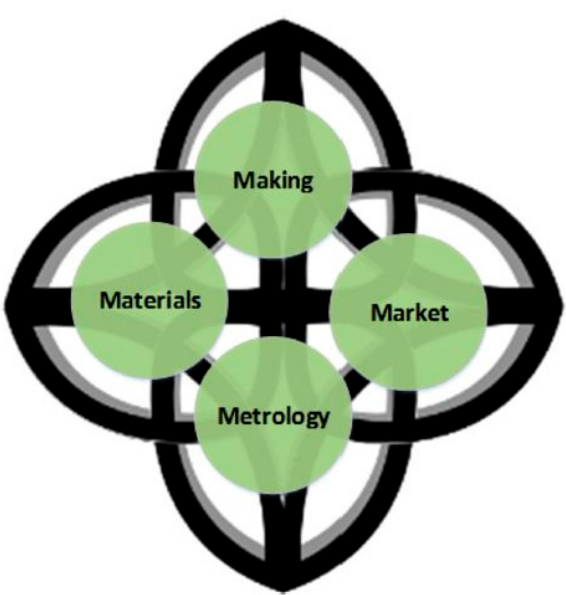
Figure 8. The four Ms (4Ms) of AM: materials, making, metrology and market. Reproduced with permission from [154]. Copyright Elsevier, 2017.